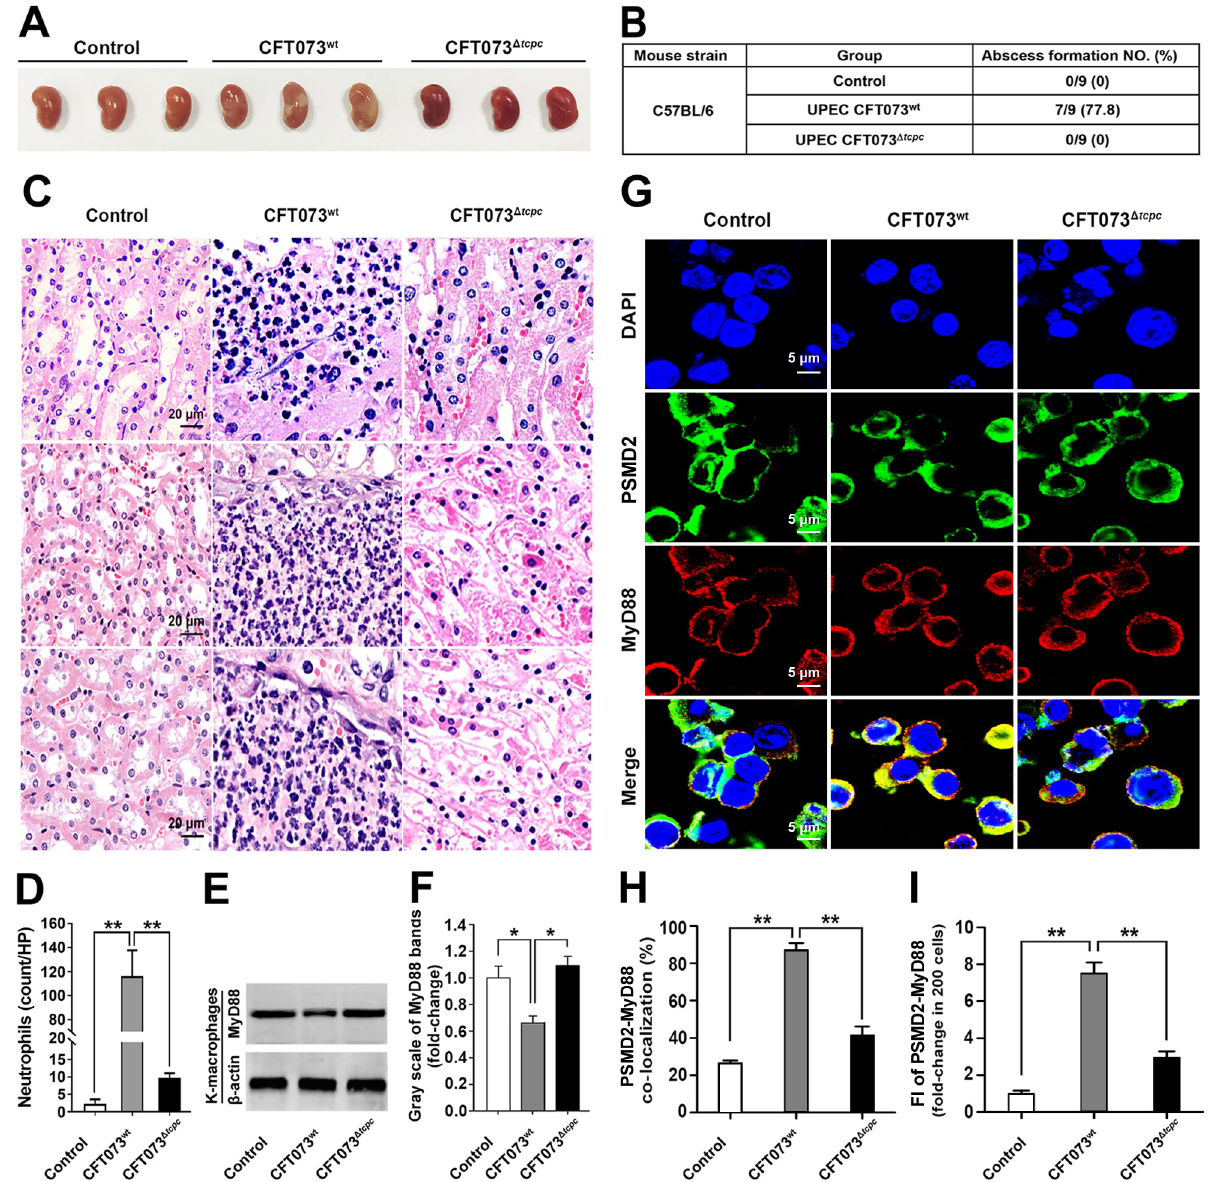
Fig 1. K-macrophages from TcpC-secreting CFT073 induced pyelonephritis murine model show decreased levels of MyD88 proteins. (A) Gross pathological changes of kidneys from CFT073 wt - or CFT073 Δ tcpc -induced murine pyelonephritis models. (B) Percentages of abscess formation in different groups. (C) Histological examinations of kidneys from pyelonephritis mouse models. Note that kidneys from CFT073 wt infections display a higher level of neutrophil infiltrates. (D) Statistical summary of neutrophil counts in C. Mean ± SD of three independent experiments were shown. �� : p < 0.01. (E) Western blot analyses of MyD88 protein levels in K-macrophages derived from model mice with pyelonephritis and control mice. (F) Gray scale analyses of bands reflecting MyD88 protein levels in experiments as described in E. The gray scale values of immunoblotting bands from control group were set as 1.0. � : p < 0.05. (G) Co-localization of MyD88 with PSMD2, determined by confocal microscopy, in K-macrophages derived from pyelonephritis murine models and from normal saline treated mice (Control). Yellow spots indicate MyD88-PSMD2 co-localization. (H) Statistical summary of MyD88-PSMD2 co-localization percentages. Mean ± SD of three independent experiments were shown. �� : p < 0.01. (I) Statistical summary of yellow fluorescence intensity (FI) reflecting the MyD88-PSMD2 co-localization in experiments as described in A. The yellow FI values from the control group were set as 1.0. �� : p <